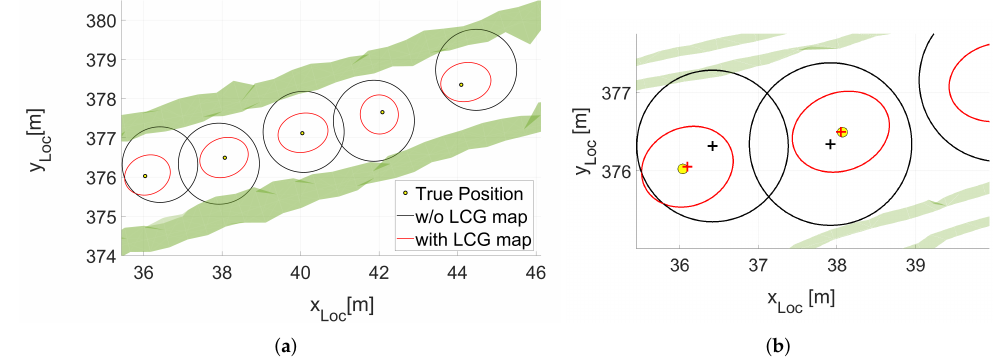
Figure 9. In ( a ), the UAV real position evolution (yellow circles) within vine rows and corresponding uncertainty ellipsods when the LCG maps and ultrasounds are (red lines) or not (black lines) included into the navigation filter. In ( b ), it is possible to observe that the true position is always inside the uncertainty ellipsoids, but it is almost aligned with the red ellipses’